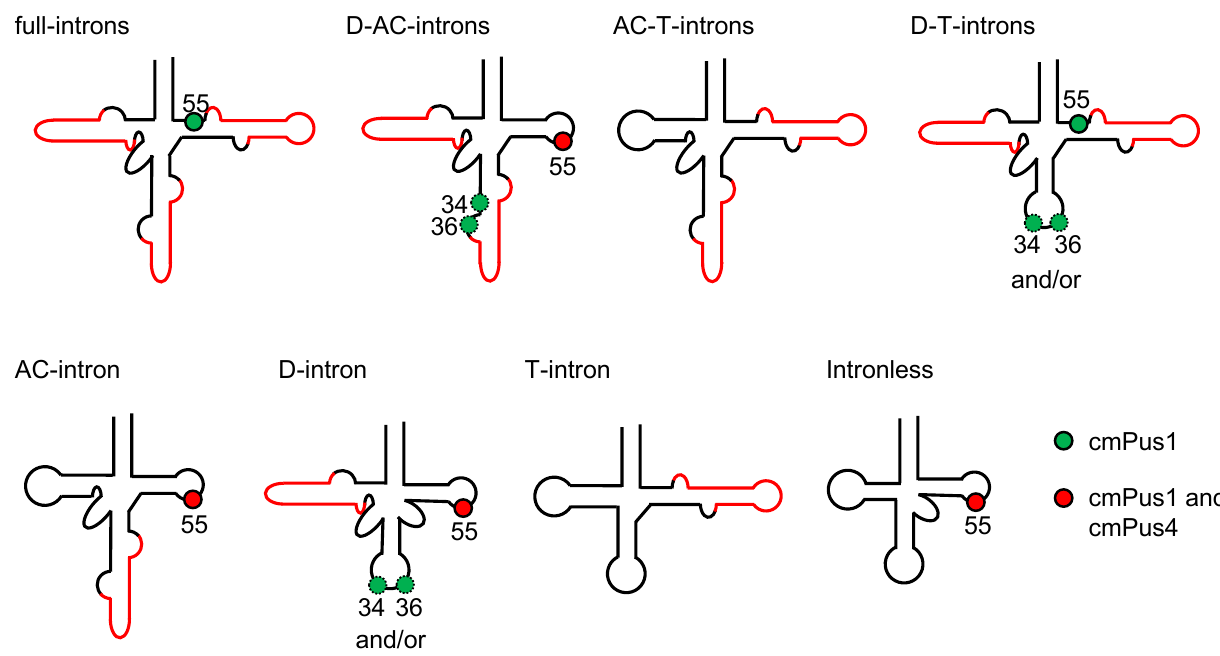
Figure 9. Possible Ψ positions in intron-less and -containing (pre)-tRNA Ile (UAU) variants introduced by cmPus1 and cmPus4. The Ψ positions resulting from treatment with cmPus1 or cmPus1 and cmPus4 are shown in green or red circles, respectively. Dotted circles indicate weak pseudouridylation activity. In the pre-tRNAs containing D-T- and D-intron, cmPus1 mediates Ψ modification at positions 34 and/or 36. Intermediates containing AC-T- or T-intron did not produce detectable Ψ conversion catalyzed by either cmPus1 or